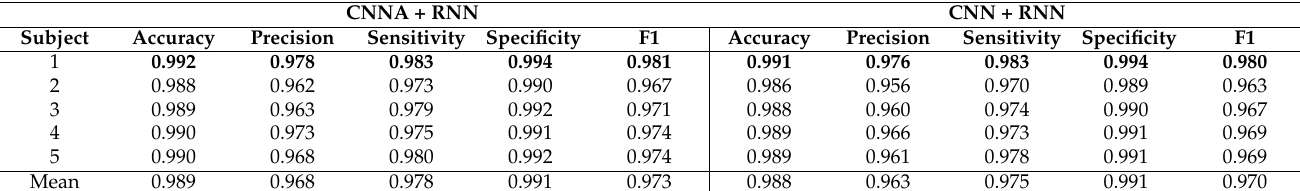
Table 8. RAW dataset